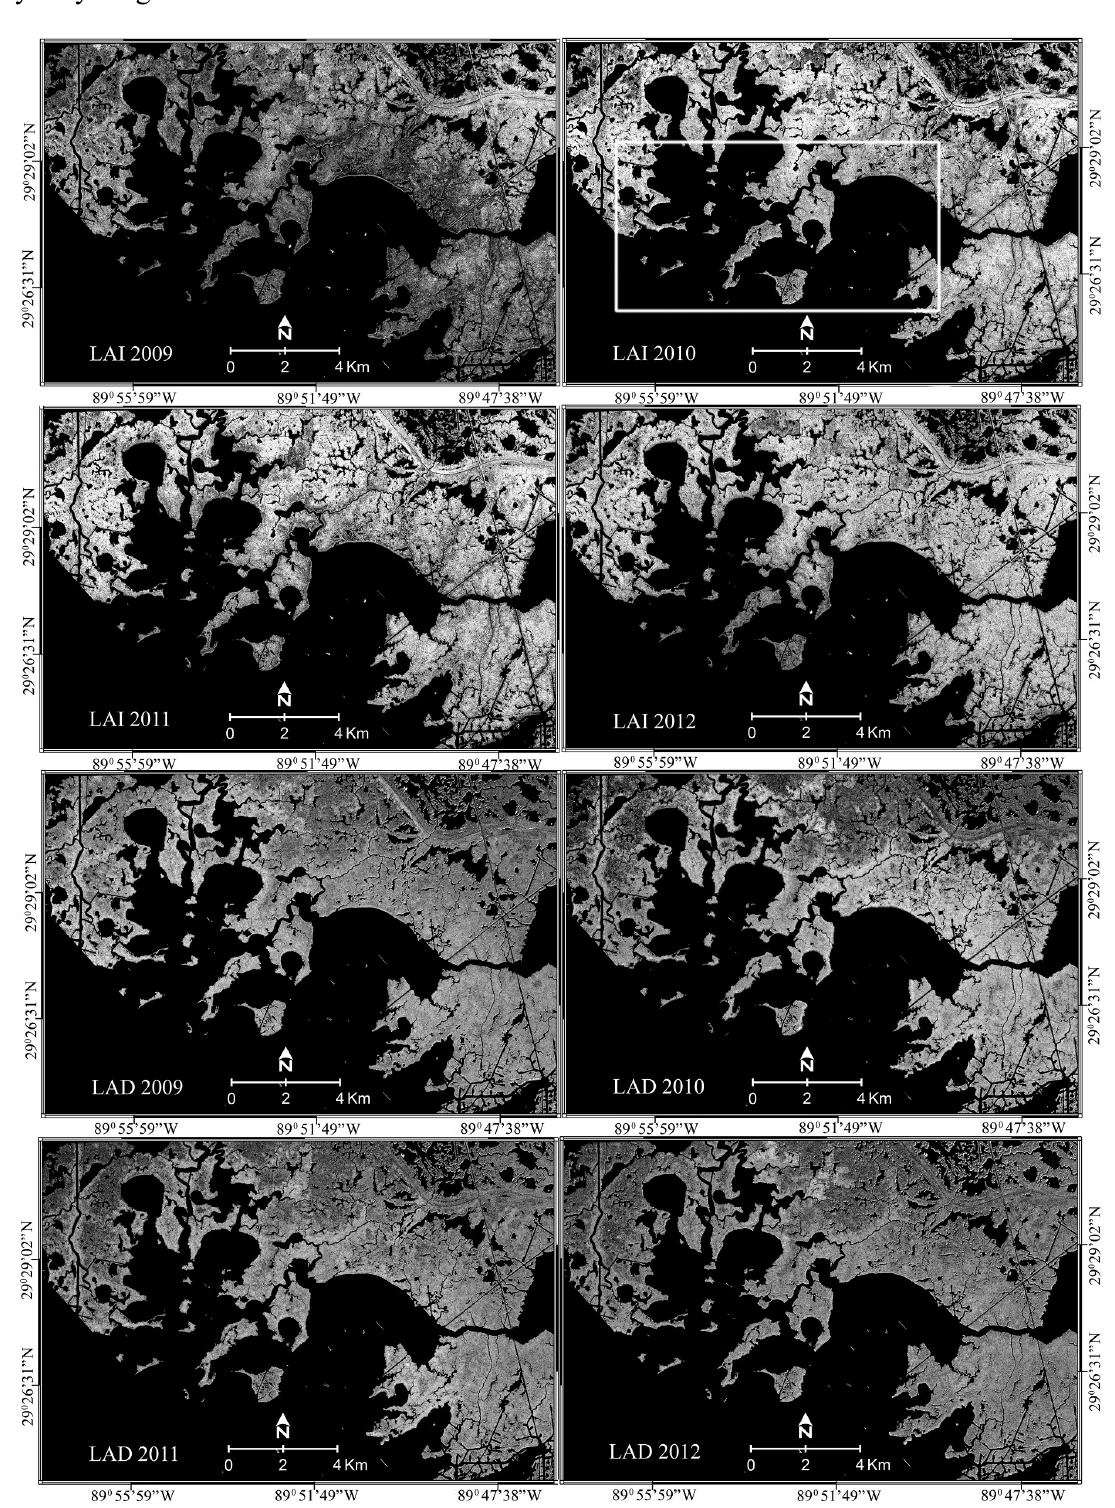
Figure 4. LAI (top 2009 to 2012) and LAD (bottom 2009 to 2012) were mapped based on regression models shown in Table 3. Brightness representing increasing LAI or LAD (Table 4) is directly comparable from year to year. The box shown on the 2010 LAI map approximately outlines the core oil impact region in Barataria